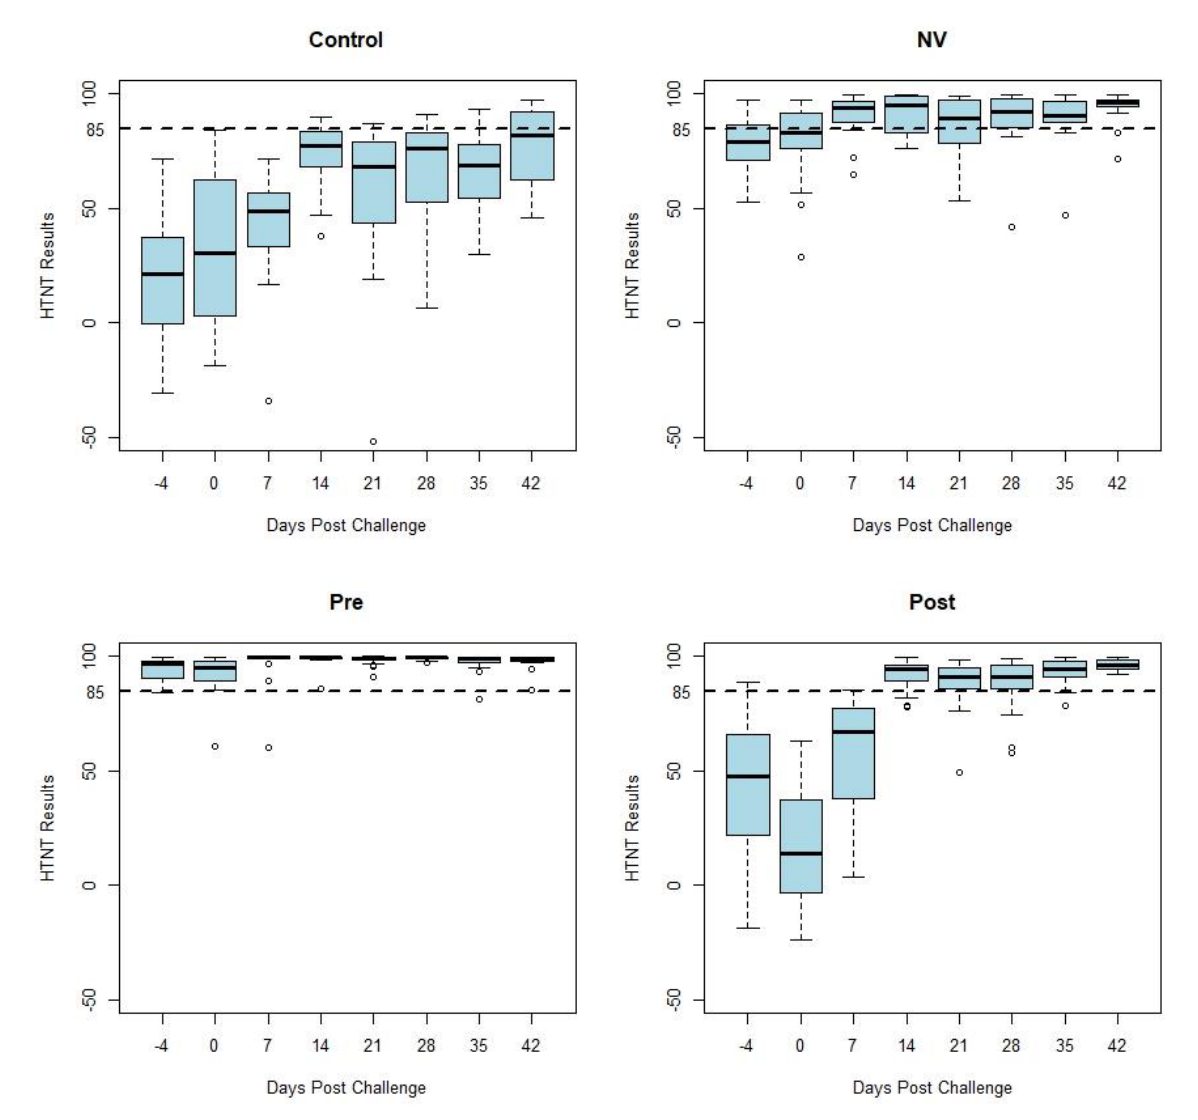
Figure 1. Box-and-whisker plots of the HTNT antibody response curves by the days post challenge for each treatment group. The middle bar represents the median value of the results by week. The hinges (top and bottom of the box) represent the first (Q1) and third (Q3) quartiles. The shaded region represents the interquartile range (IQR). The whiskers are determined as follows: Top whisker = Q3 + 1.5 * IQR; Bottom whisker = Q1 + 1.5 * IQR. If no data point is at the calculated value, the next data point closest to Q1 or Q3 is the limit of the whisker. Open circles ( ◦ ) indicate outliers. A cut of 85 is denoted by the dashed line at 85 on the y-axis.